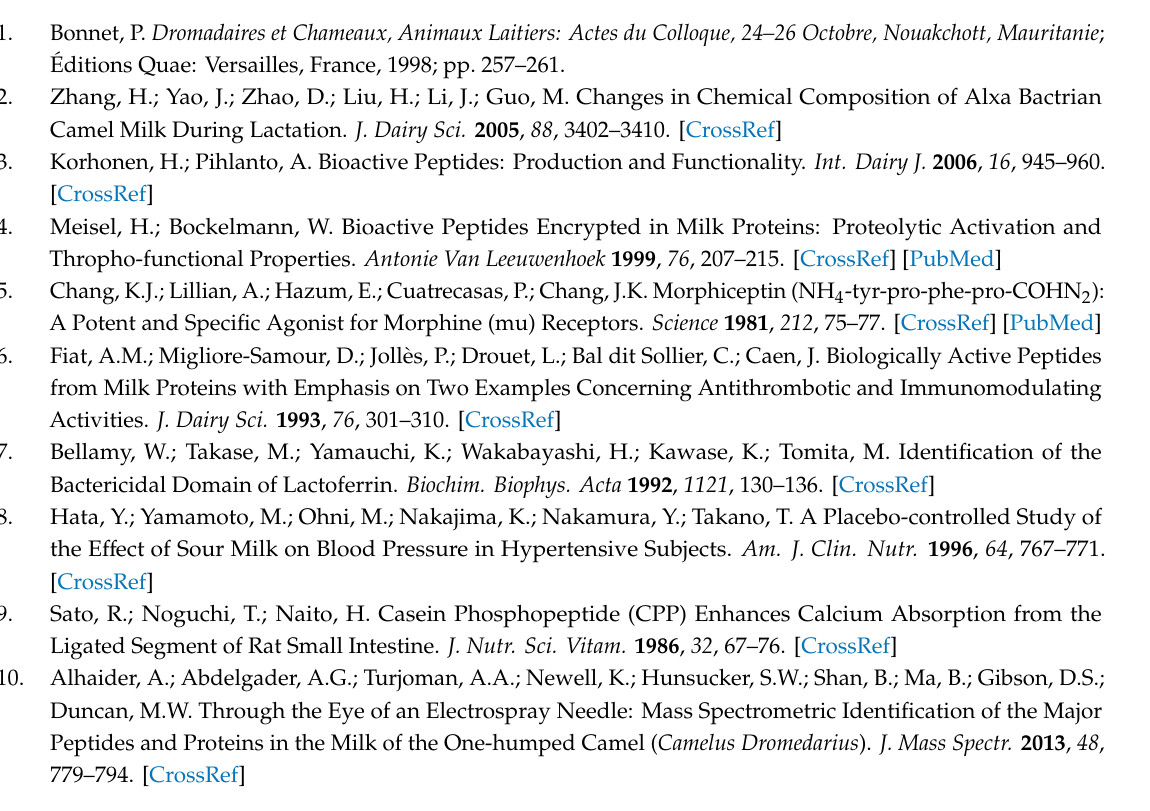
Figure S1: MS spectrum of C3–3 (A) and MS / MS identification of a peak of m / z 1021.522 (B), Figure S2: MS spectrum of C3–4 (A) and MS / MS identification of a peak of m / z 1177.576 (B), Figure S3: MS spectrum of C3–5 (A) and MS / MS identification of two peaks of m / z 1098.615 (B) and 1213.633 (C), Figure S4: MS spectrum of C3–6 (A) and MS / MS identification of a peak of m / z 865.548 (B), Figure S5: MS spectrum of C3–8 (A) and MS / MS identification of two peaks of m / z 674.370 (B) and 966.588 (C), Figure S6: MS spectrum of C3–9 (A) and MS / MS identification of two peaks of m / z 759.415 (B) and 1544.925 (C), Figure S7: MS spectrum of C3–10 (A) and MS / MS identification of a peak of m / z 929.574 (B), Figure S8: MS spectrum of C3–11 (A) and MS / MS identification of a peak of m / z 1019.540 (B), Figure S9: MS spectrum of H1–1 (A) and MS / MS identification of two peaks of m / z 816.432 (B) and 790.394 (C), Figure S10: MS spectrum of H1–2 (A) and MS / MS identification of a peak of m / z 951.458 (B), Figure S11: MS spectrum of H1–3 (A) and MS / MS identification of tree peaks of m / z 823.490 (B), 944.491 (C), and 927.470 (D), Figure S12: MS spectrum of H1–4 (A) and MS / MS identification of two peaks of m / z 1129.575 (B) and 1157.581 (C), Figure S13: MS spectrum of H1–6 (A) and MS / MS identification of two peaks of m / z 1129.575 (B) and 1157.581 (C), Figure S14: MS spectrum of H1–7 (A) and MS / MS identification of a peak of m / z 826.388 (B), Figure S15: MS spectrum of H1–8 (A) and MS / MS identification of two peaks of m / z 739.356 (B) and 786.410 (C), Figure S16: MS spectrum of H1–10 (A) and MS / MS identification of a peak of m / z 871.484 (B), Figure S17: MS spectrum of H1–13 (A) and MS / MS identification of two peaks of m / z 675.222 (B) and 1050.508 (C), Figure S18: MS spectrum of H1–14 (A) and MS / MS identification of three peaks of m / z 785.358 (B), 933.512 (C), and 1195.652 (D), Figure S19: MS spectrum of H1–19 (A) and MS / MS identification of two peaks of m / z 711.451 (B) and 1797.000 (C), Figure S20: MS spectrum of H1–20 (A) and MS / MS identification of two peaks of m / z 3084.609 (B) and 3624.809 (C), Figure S21: MS spectrum of H1–21 (A) and MS / MS identification of a peak of m / z 2928.835 (B), Figure S22: MS spectrum of H1–22 (A) and MS / MS identification of two peaks of m / z 683.468 (B) and 3652.638